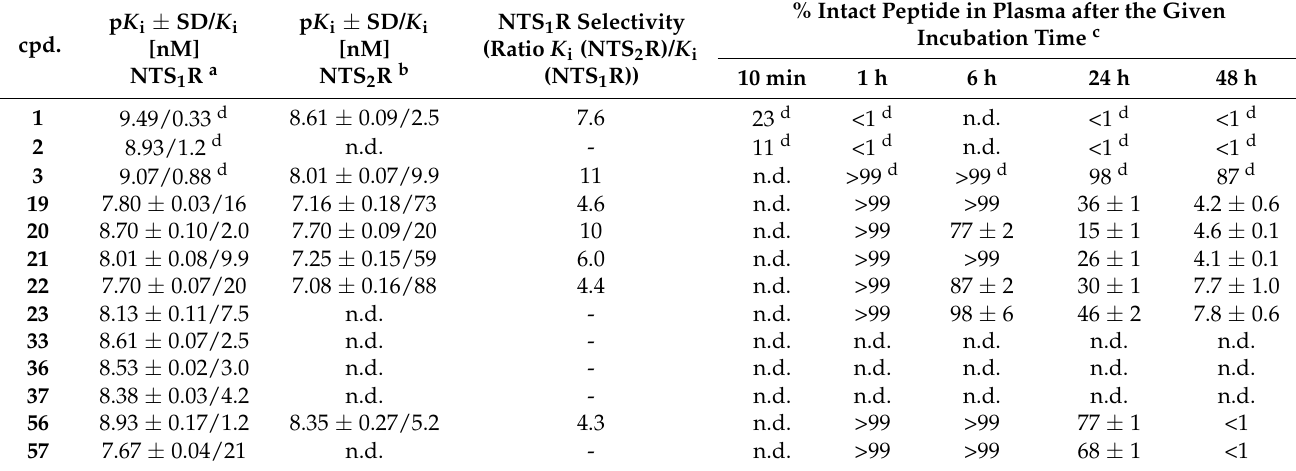
Table 2. NTS 1 R affinities of 1–3 , 19–23 , 33 , 36 , 37 , 56, and 57 , NTS 2 R affinities of 1 , 3 , 19–22 and 56 , NTS 1 R selectivities of 1 , 3 , 19–22 and 56 , and in vitro plasma stabilities of 1–3 , 19–23 , 56, and 57 , determined at 37 ◦